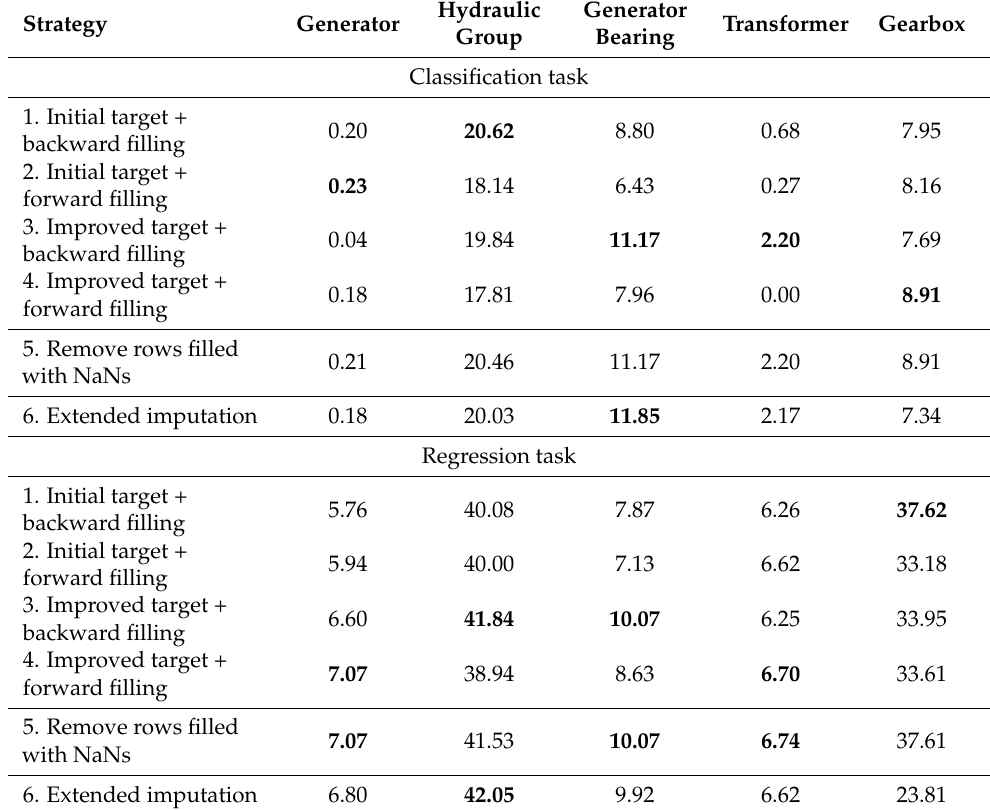
Table 3. Values of F1 score on validation set for considered data preprocessing strategies. Values are presented in